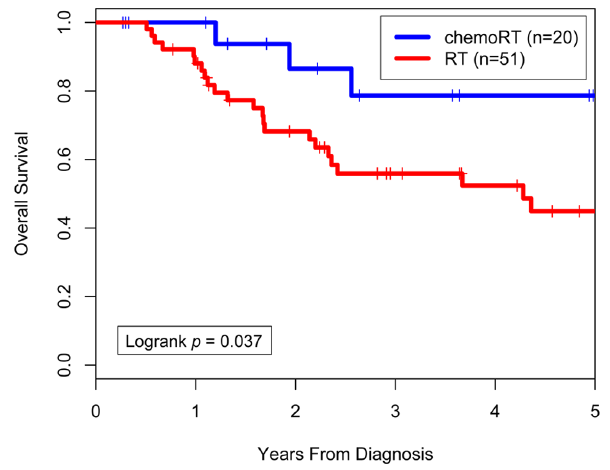
Figure 1. Overall survival by treatment (chemoradiation therapy or radiation therapy alone).